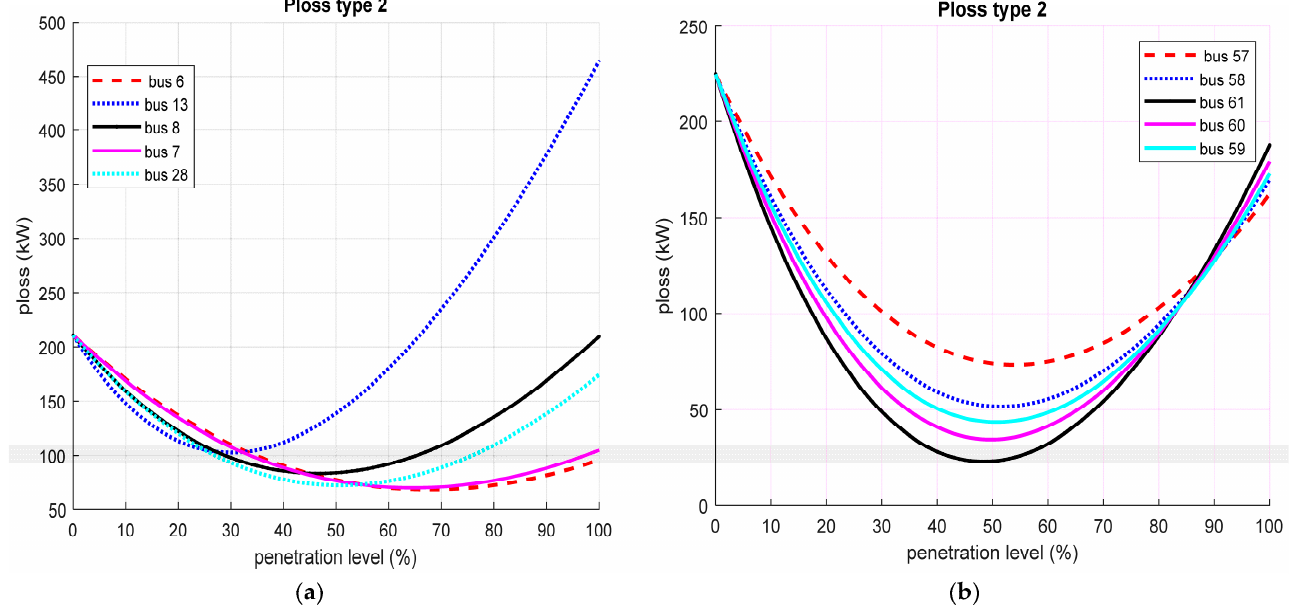
Figure 16. Real power loss when Type 2 DG was connected to selected buses of IEEE ( a ) 33-bus ( b ) 69-bus RDNs.